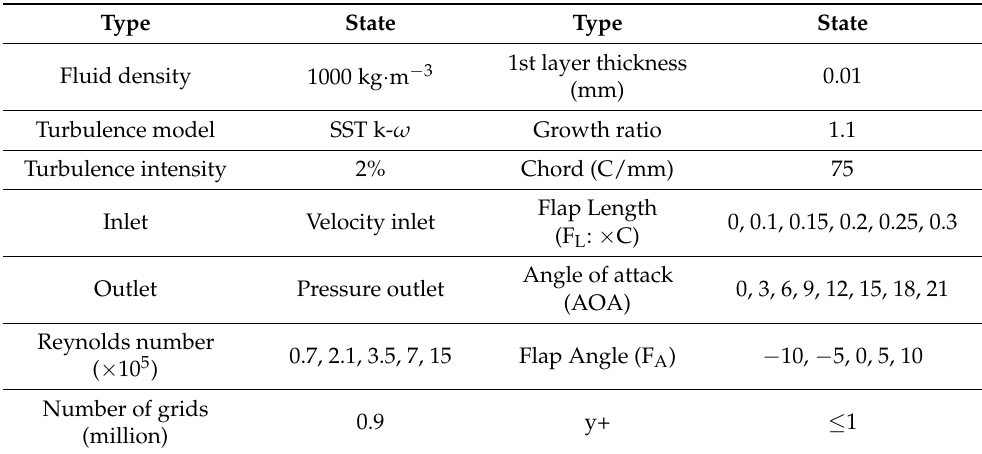
Table 1. CFD model.